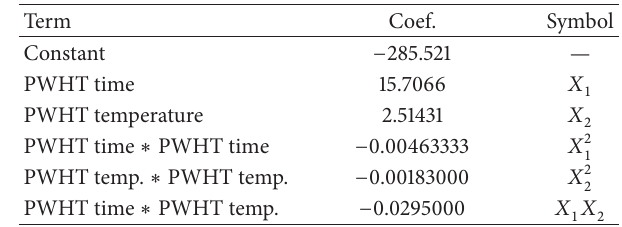
Table 5: Estimated regression coefficients for tensile strength.